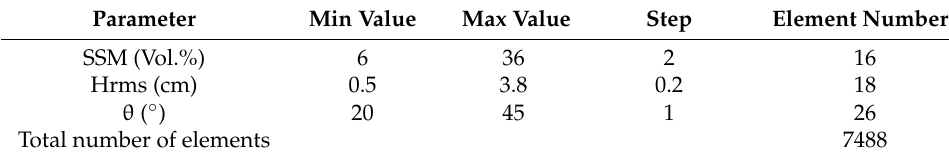
Table 2. Minimum and maximum values of the IEM input